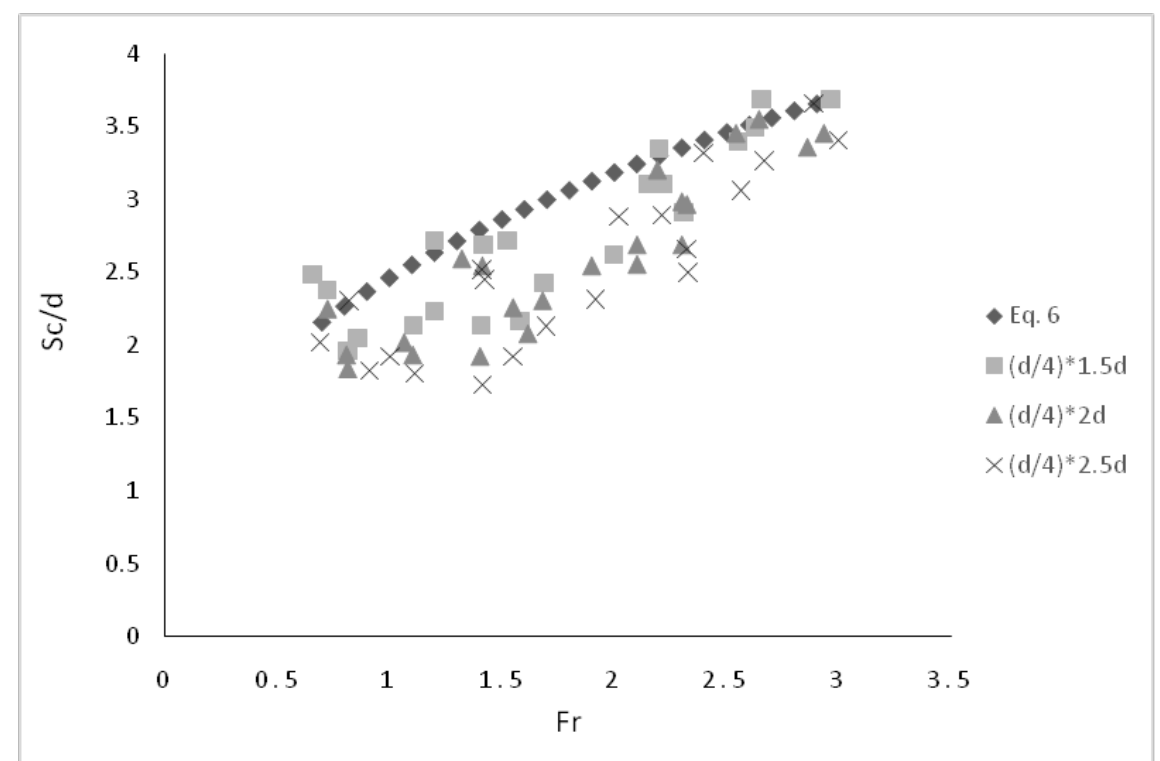
Fig. 7 The experimental results of the critical submergence at various Froude numbers. (Plates with height of